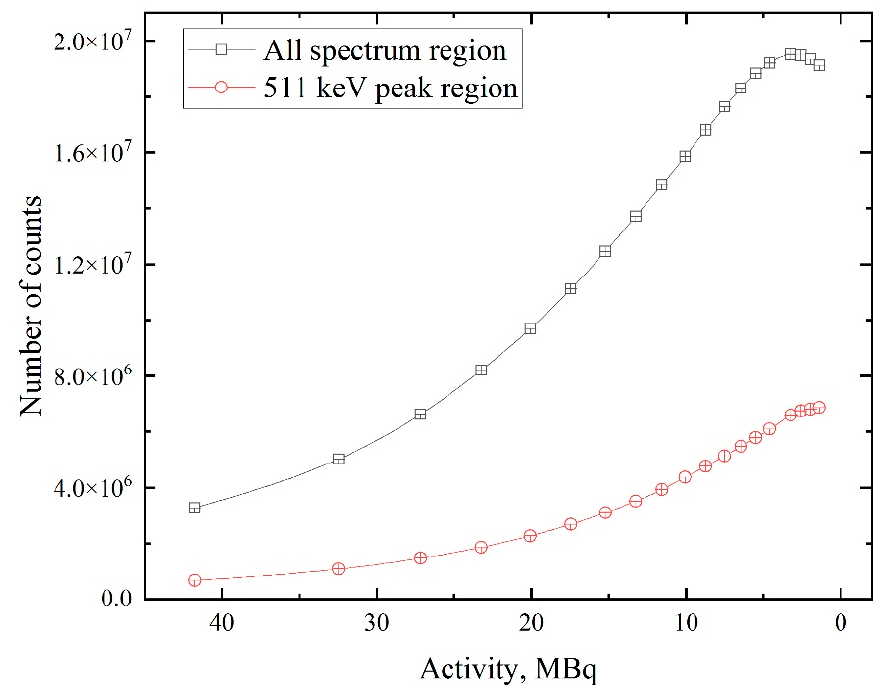
Figure 5. Dependence of the total number of counts in the whole spectrum of 64 Cu isotope and in the range of positron annihilation line (511 keV) on the activity.